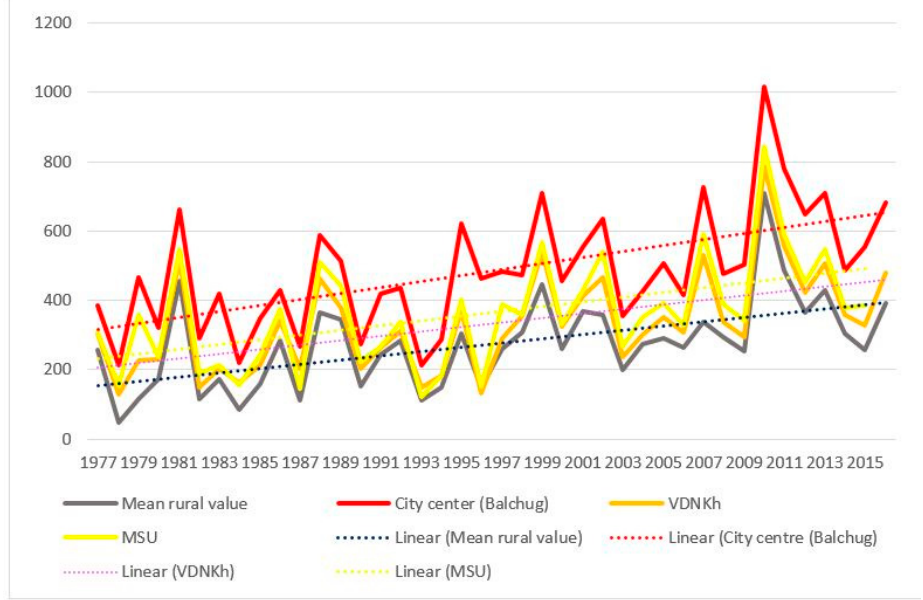
Figure 5. Sums of effective temperatures accumulated in Moscow city and suburban areas during the years 1977 to 2016 (dashed lines show linear trends).